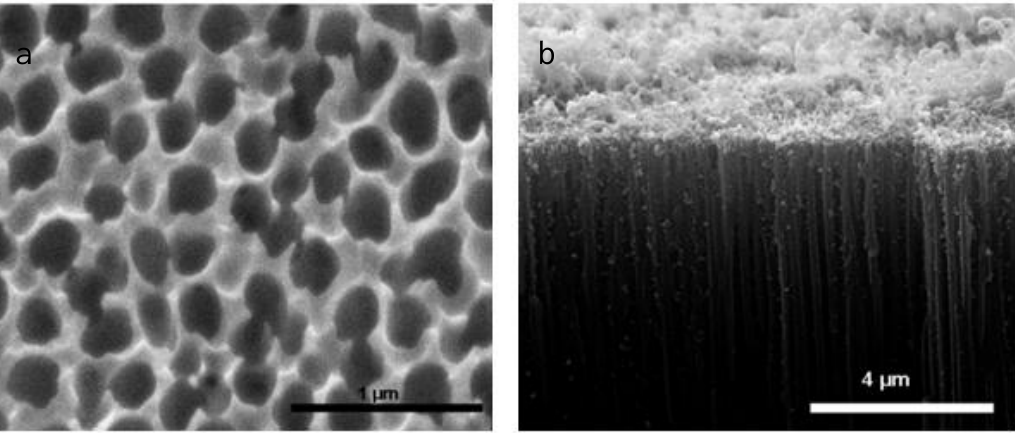
Figure 7. ( a ) SEM image of the AAO template and ( b ) cross-sectional SEM image of the vertically aligned CNTs-AAO [59].